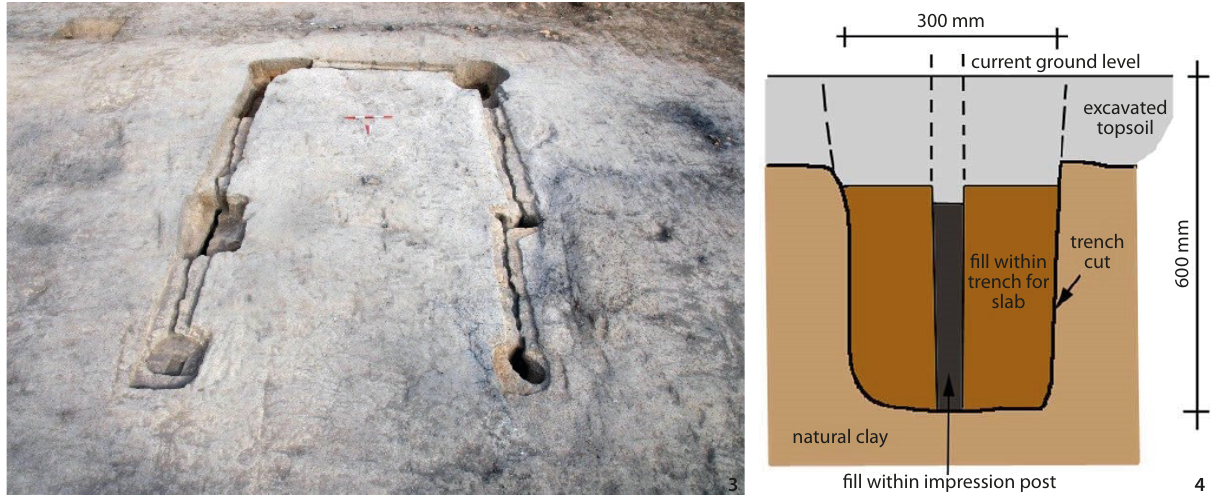
Figure 3 Gavin house site, Penrith, Australia, evidence of posts and palisade walling (Source: Archaeology and Heritage P/L). Figure 4 Gavin house site, Penrith, Australia, evidence of palisade wall (Source: Franz Reidel, AAH. Archaeology and Heritage